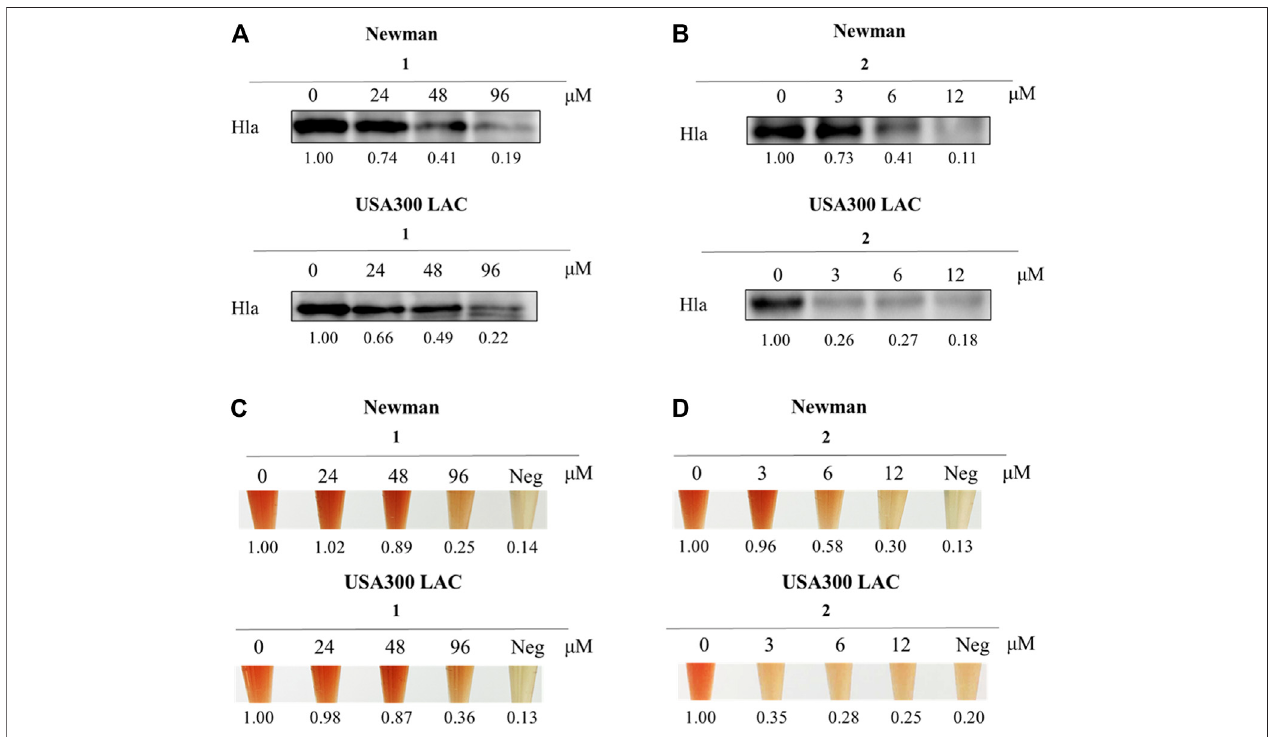
FIGURE 4 | Compound 2 (LCEB) showed outstanding inhibition against Hla in both Newman and USA300 LAC strains. (A) Western blotting analysis of Hla expression in Newman and USA300 LAC strains treated with different concentrations of 1 (LCEA). (B) Western blotting analysis of Hla expression in Newman and USA300 LAC strains treated with different concentrations of LCEB. (C) Hemolysis assay in Newman and USA300 LAC strains treated with different concentrations of LCEA. (D) Hemolysis assay in Newman and USA300 LAC strains treated with different concentrations of LCEB.